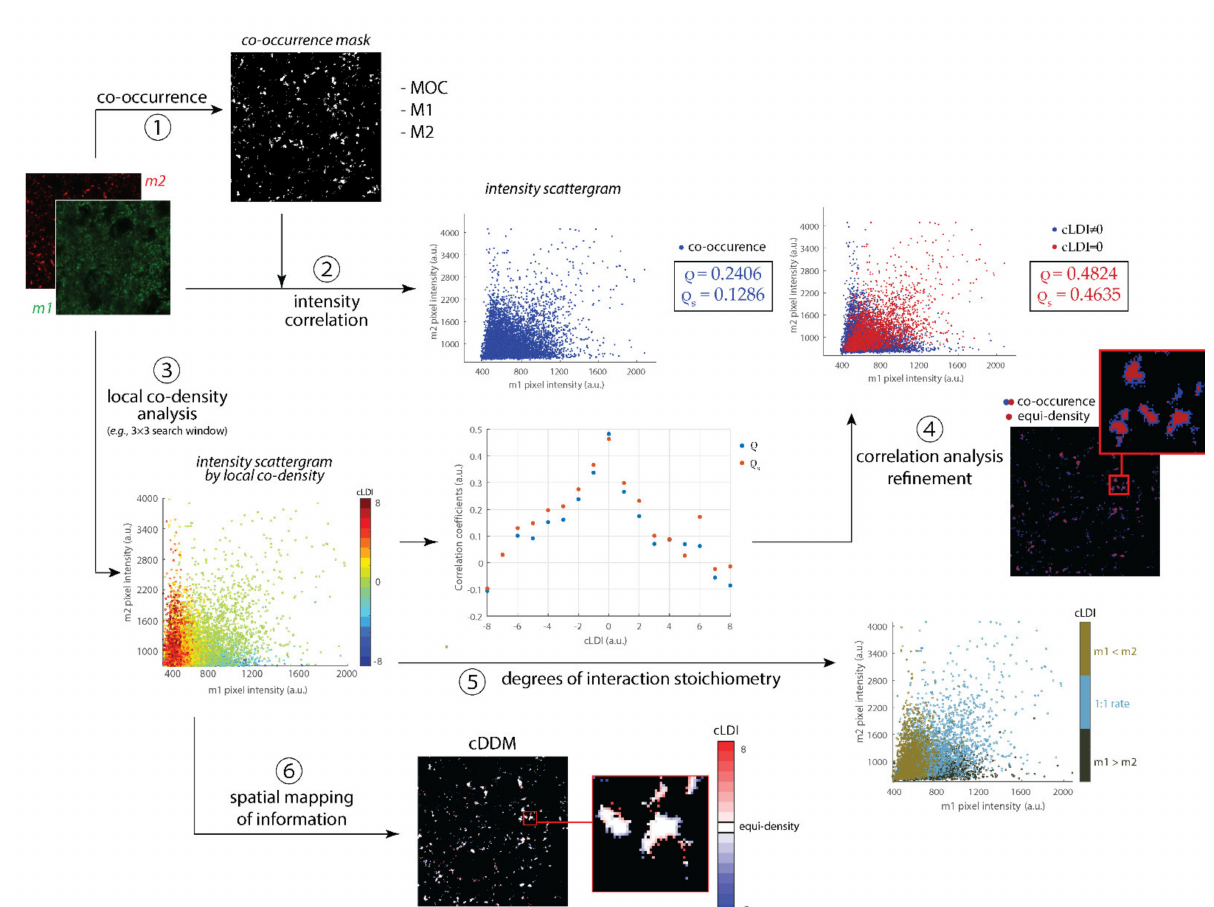
Figure 2. Functional implications of coDDM. Starting from a couple of marked images (m1 and m2), colocalization is usually quantified as a combination of markers overlap (by co-occurrence mask and Manders’ MOC, M 1 and M 2 coefficients computation, 1 (cid:13) ) and intensity correlation (primarily by ρ and ρ s correlation coefficients, 2 (cid:13) ). By cLDIs computation, co-occurrence pixels can be further partitioned by their local co-density and resulting groups visualized in a pseudo-color scattergram ( 3 (cid:13) ). When quantifying colocalization through markers’ intensity correlation, the analysis specificity can be increased by narrowing the computational domain from the co-occurrence to the equi-density region (i.e., made of pixels with cLDI = 0, 4 (cid:13) ). In addition, being based on density instead of intensity, cLDIs are more appropriate for estimating markers’ relative abundance ( 5 (cid:13) ). Finally, cDDM permits to preserve the spatiality of original images, additionally coding it with colors for the regional investigation of cLDI distribution ( 6 (cid:13) ). Details of presented scatterplot data in Supplementary Figure